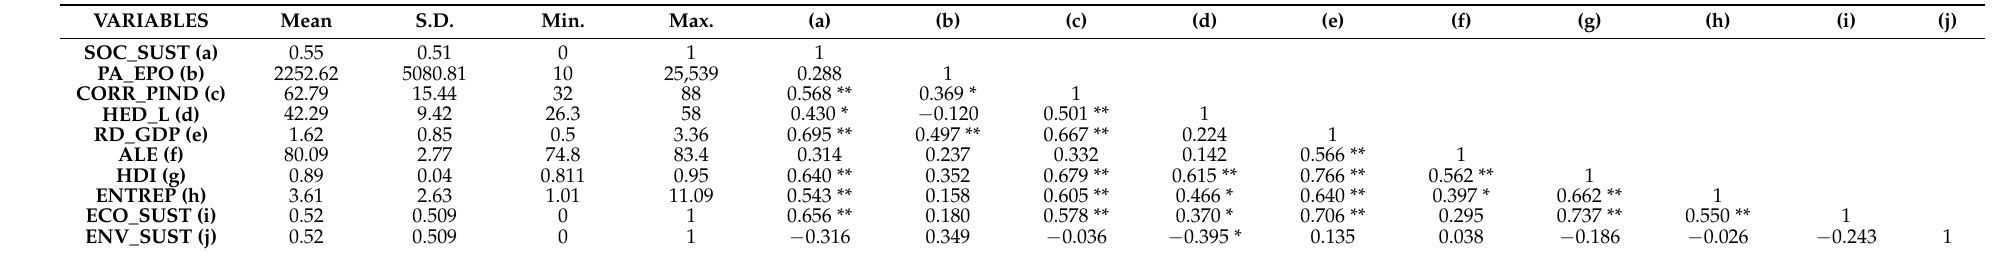
Table 4. Descriptive statistics and